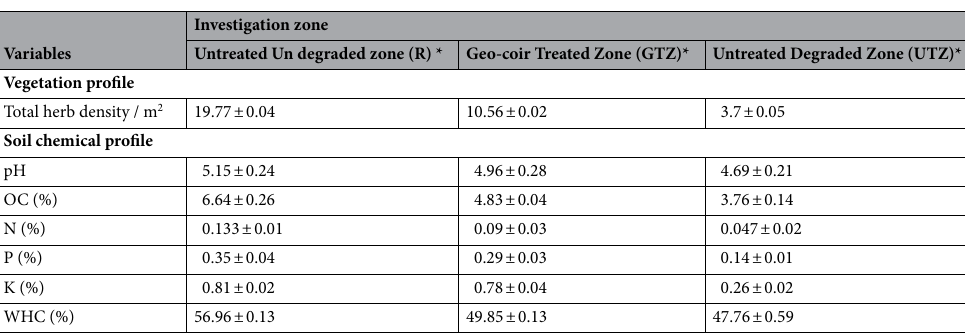
Table 4. Chemical characteristics of the different soil zones (upto 30 cm depth) from R, GTZ and UTZ in the Dayara bugyal (n = 3 per investigation zone; 50 random soil cores per replicate for soil analysis ; 30 randomly placed quadrates of 1 × 1 m in 5-50 m in triplicate per investigation zone). *(mean ± standard